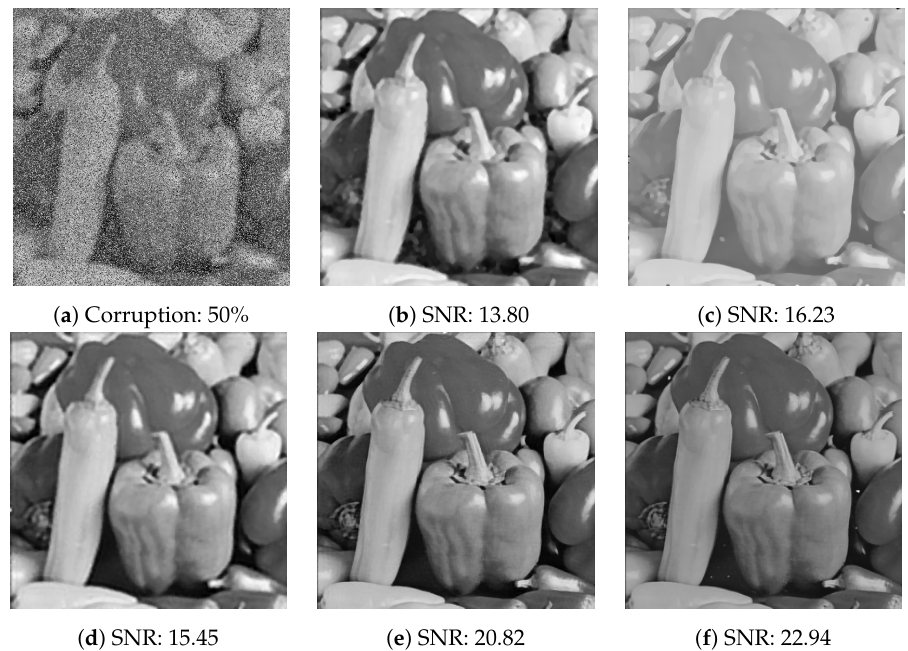
Figure 18. Recovered images on Pepper image corrupted by random-valued noise with noise level 50%. ( a ) Corrupted image. ( b ) Lp-ADMM. ( c ) AOP. ( d ) PDA. ( e ) L0TV-PADMM. ( f )